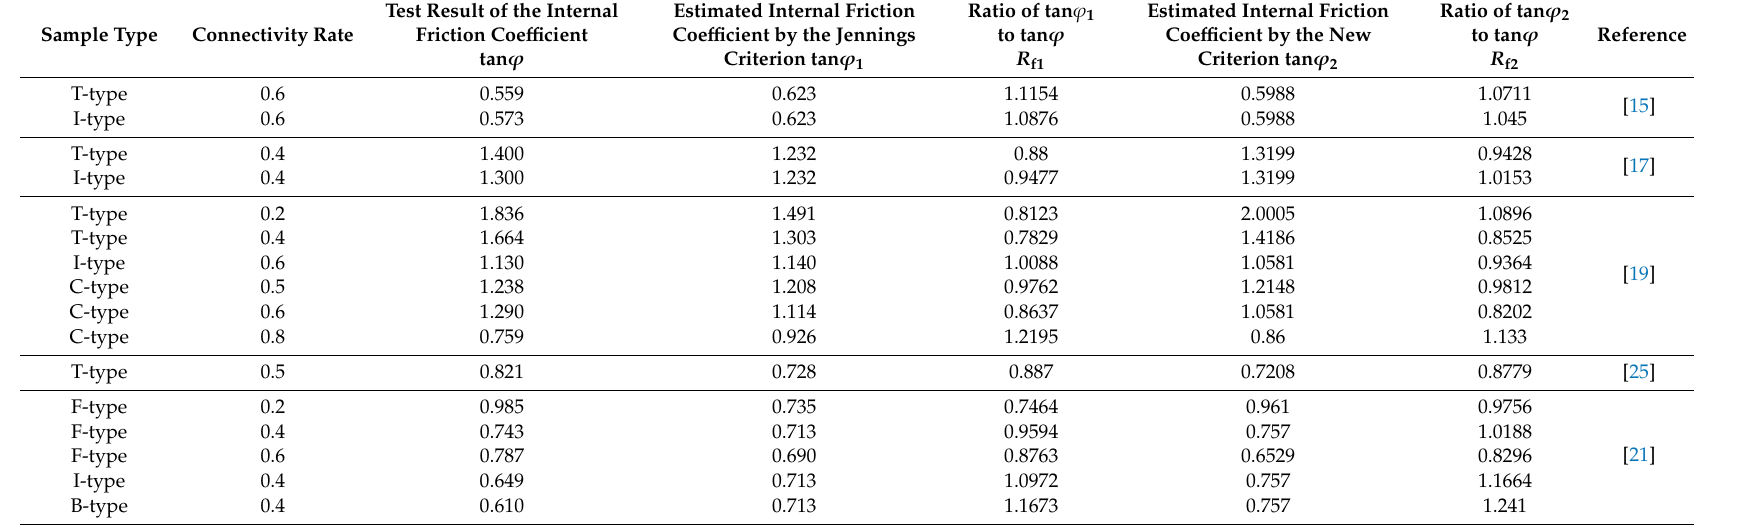
Table 5. Comparison of the internal friction coe ffi cients estimated by the Jennings and new